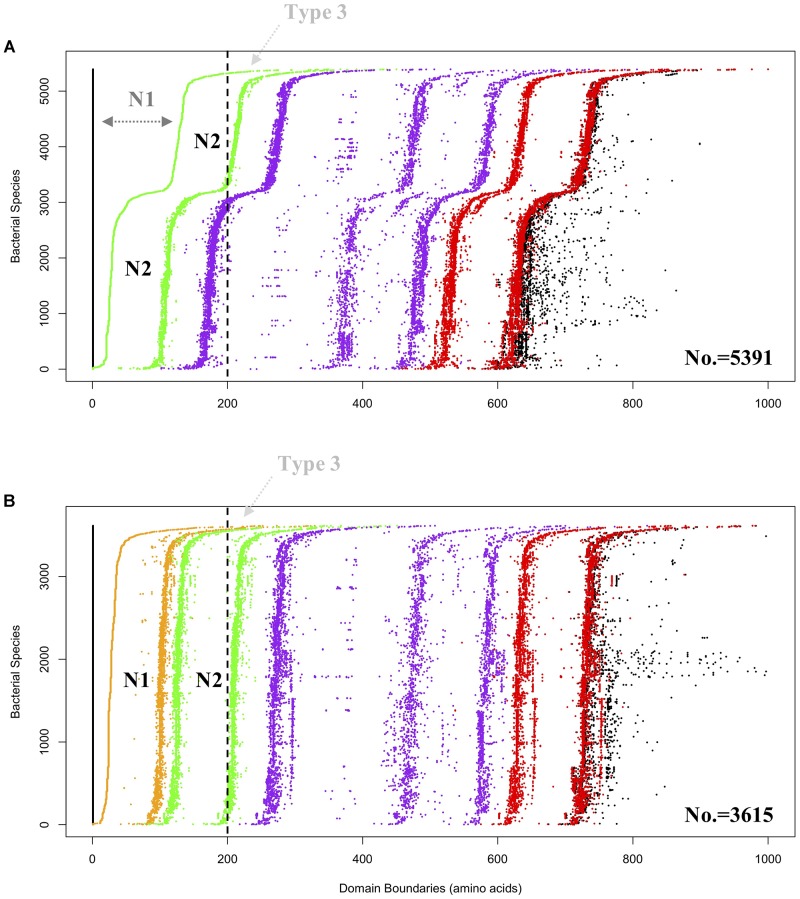
Domain visualization of bacterial GBEs in (A) Group 1 (5,391 sequences) and (B) Group 2 (3,615 sequences). Domain boundaries are denoted by dots in different colors, which are N1 (orange), CBM48 (green). Alpha-amylase (purple) and C-terminus (red). In (A) Group 1, dark gray N1 denoted region with dashed arrow line means that the region is too remotely related with N2 domain and cannot be detected by HMMs, which might represent a subgroup of Type 1 GBEs. Vertically dashed black line is arbitrarily drawn at 200 aa. GBEs with first detectable domain, N2 (green dots in A) or N1 (orange dots in B), starting from the vertical dashed line (black) are considered as potential Type 3 enzymes and denoted with light gray Type 3 and dashed arrow line. Boundaries of complete protein sequences are denoted in black dots. According to the domain organization, it could be inferred that both CBM48 and alpha-amylase domains experience duplications during the evolutionary process.